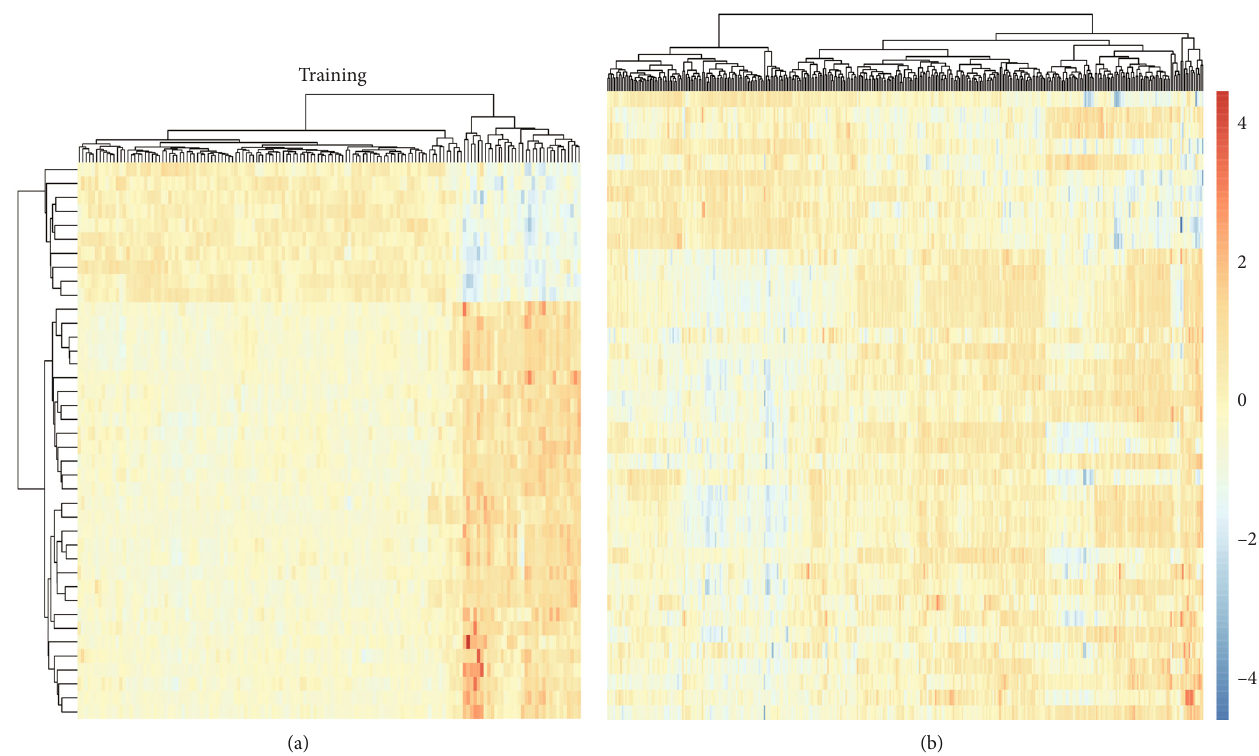
Figure 3: Heatmaps of training and veri fi cation set expression